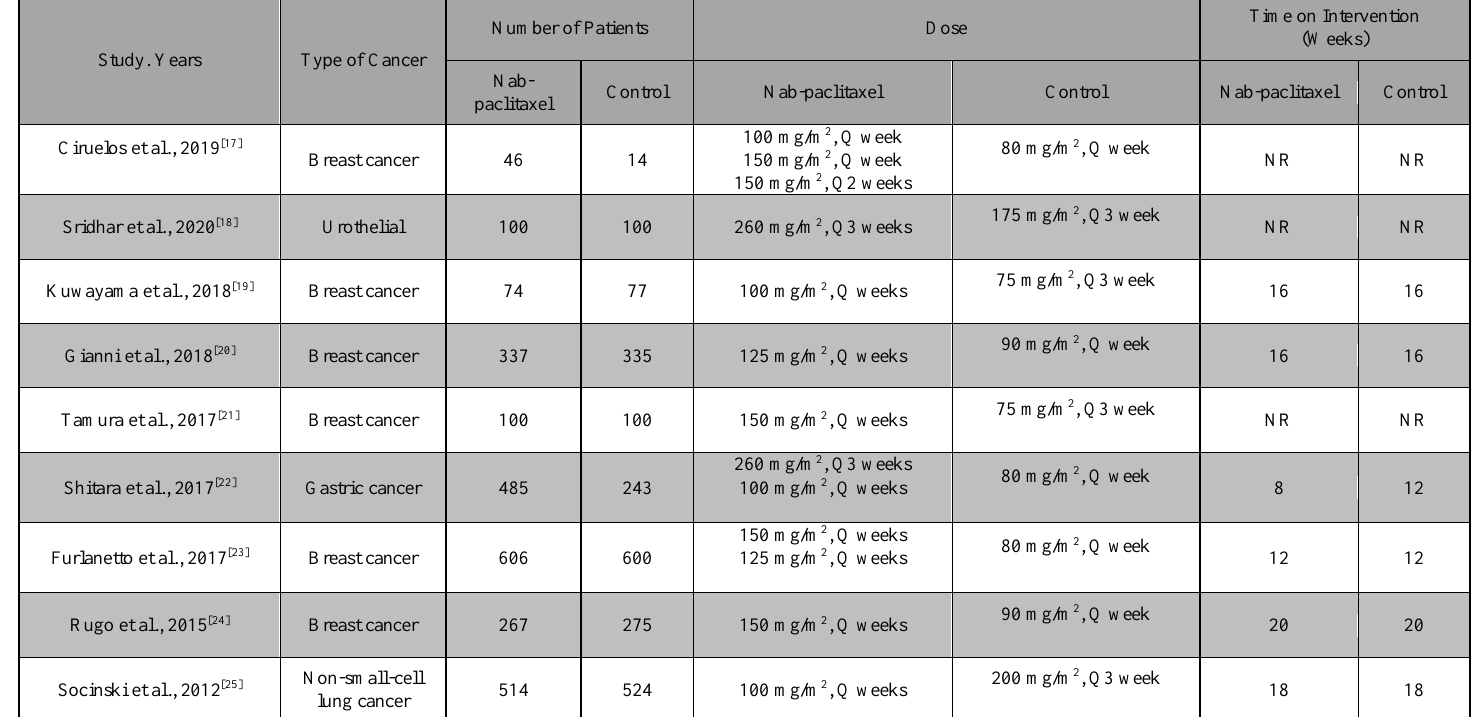
Table 2. Summary of the findings reported in selected